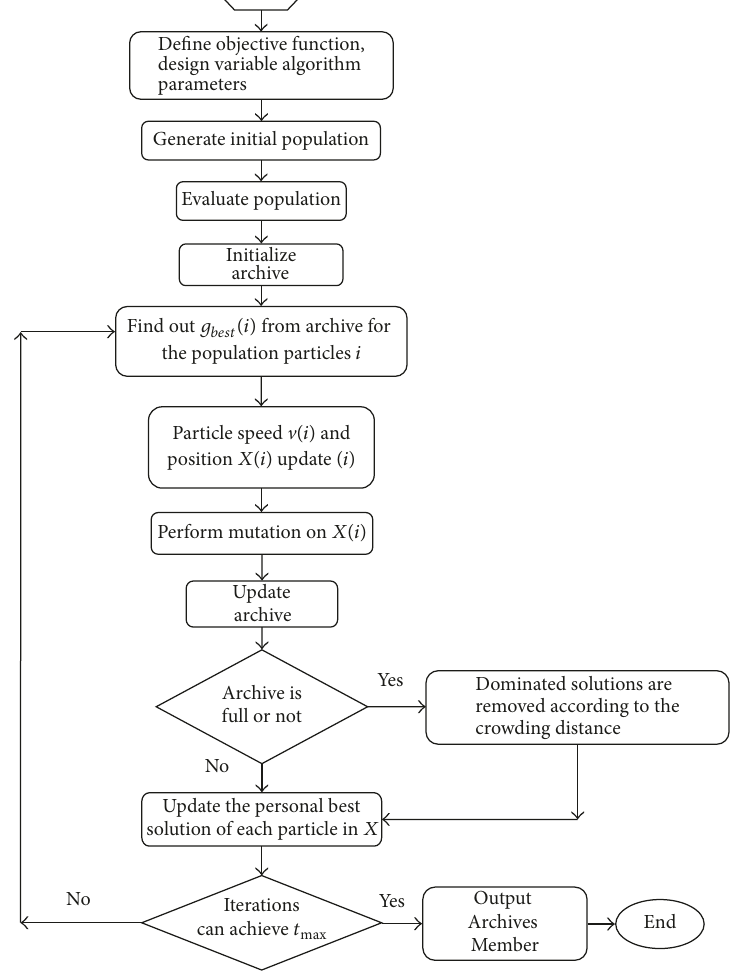
Figure 1: Flowchart of the proposed algorithm for multiobjective optimization